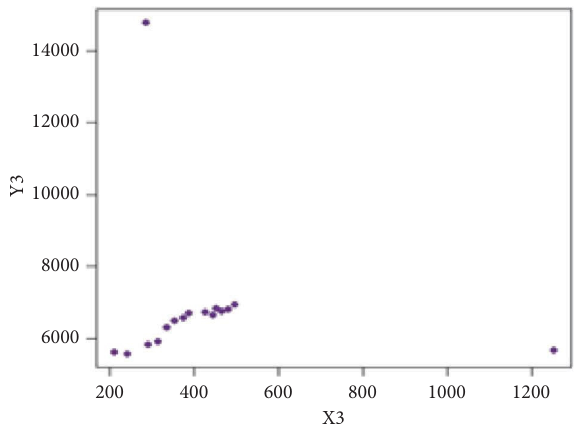
Figure 3: Stratum-III